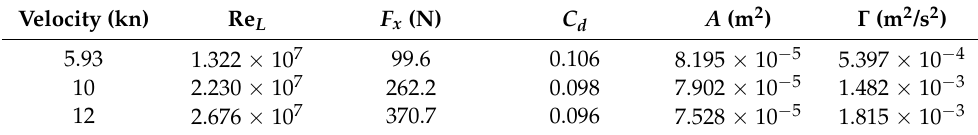
Table 2. The drag and structural parameters of the horseshoe vortex at three velocities.